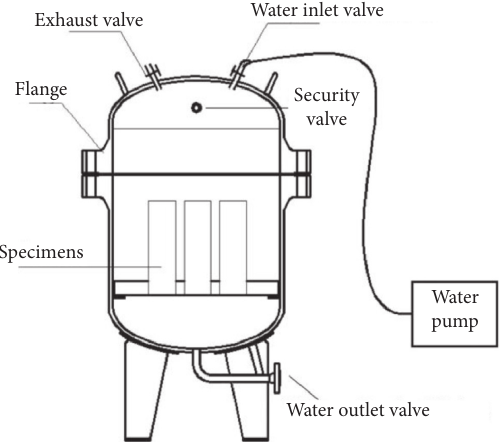
Figure 1: High water pressure device.